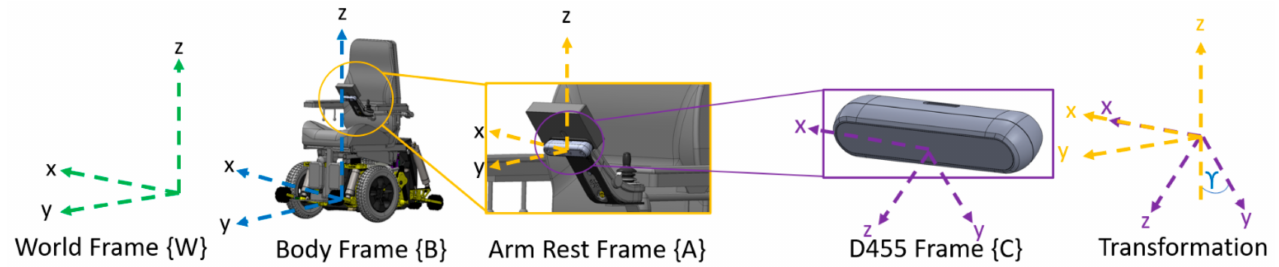
Figure 5. Rigid body